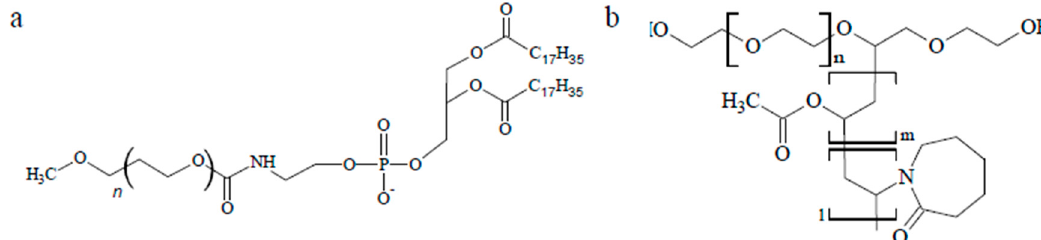
Figure 1. Chemical structure of ( a ) distearoyl phosphatidyl ethanolamine (DSPE)-PEG2000 and ( b ) Soluplus.